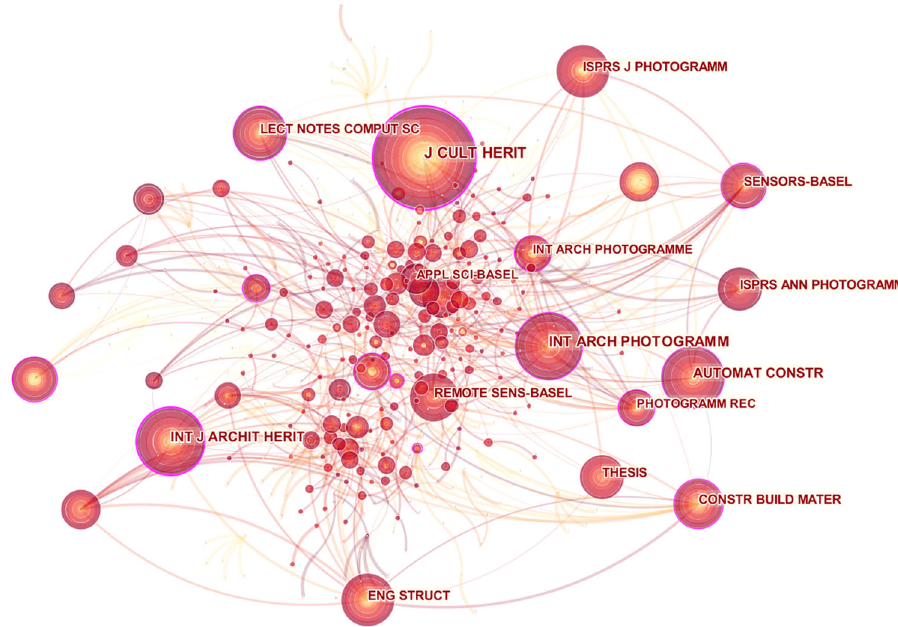
Fig. 6 Analysis of journal co-citations for HBIM research. Analysis of journal co-citations for HBIM research analyzed by CiteSpace bibliometric analysis software.